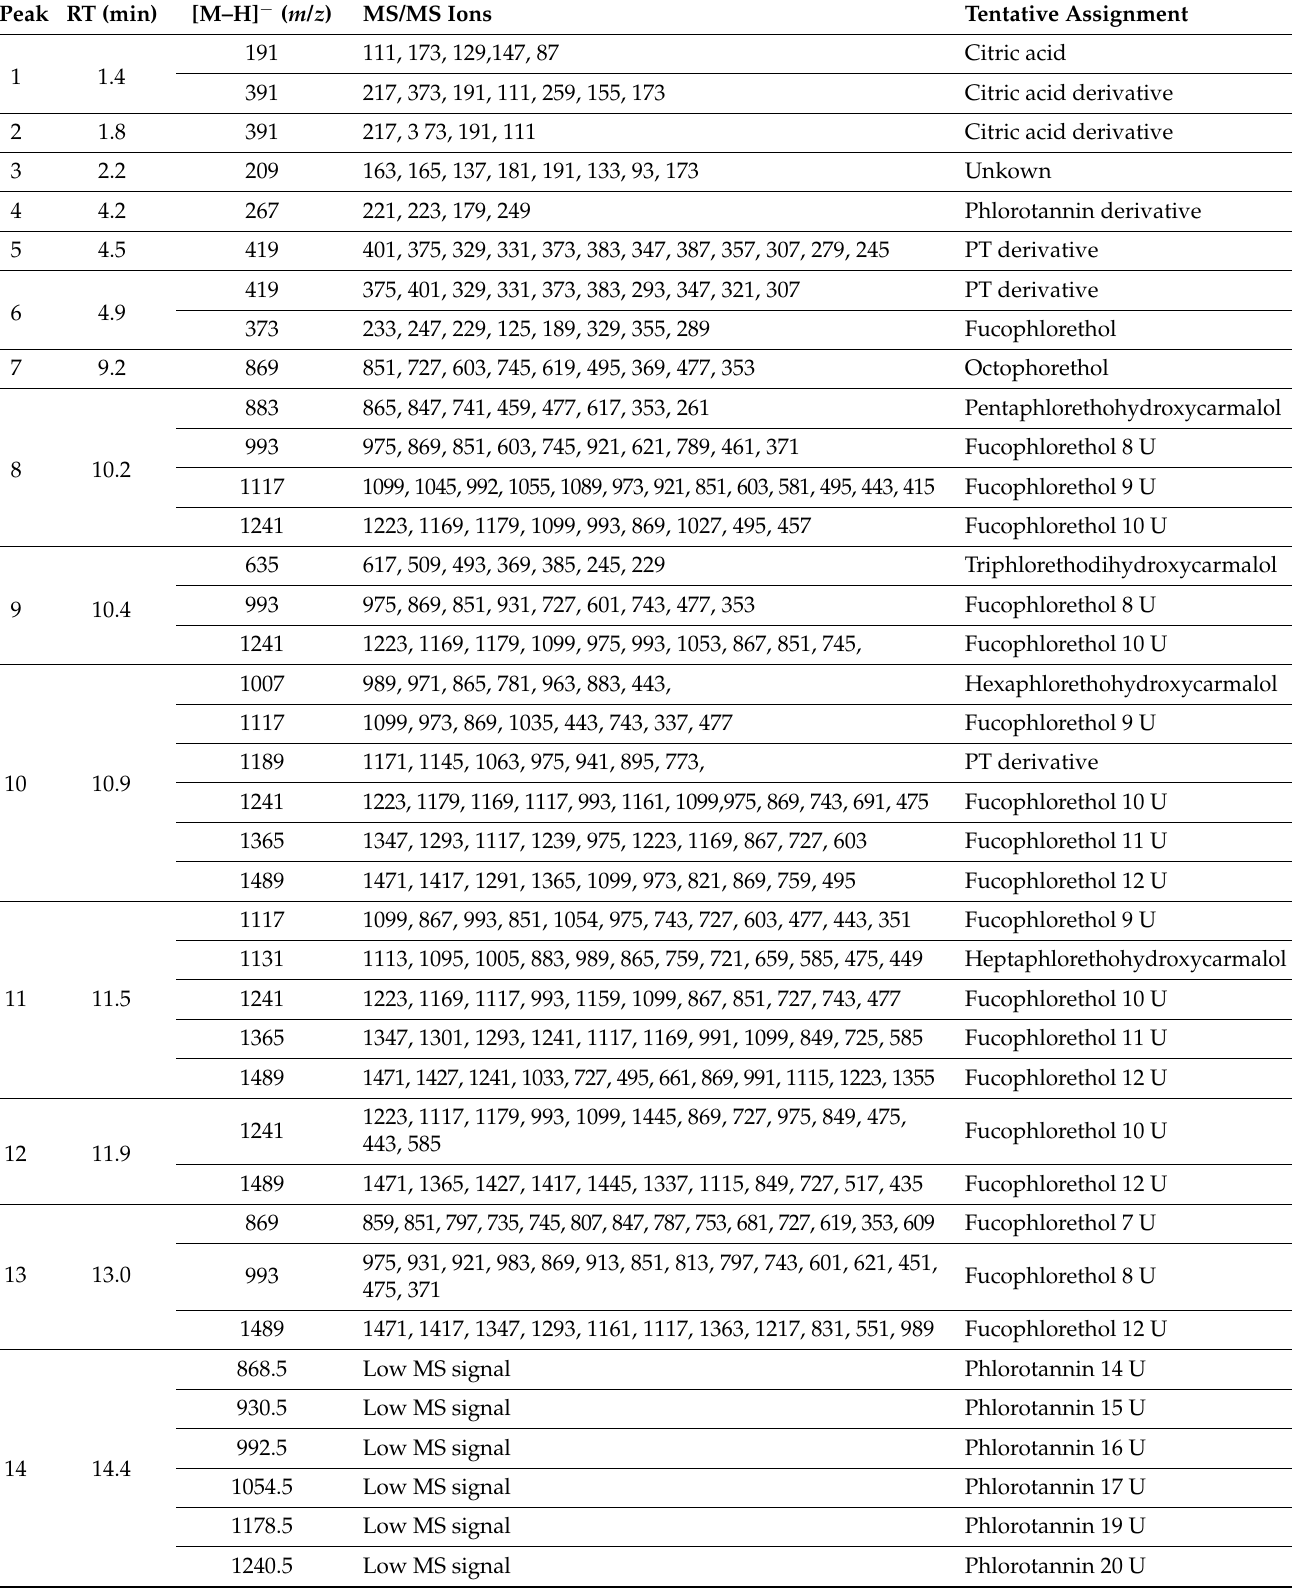
Table 2. Assignment of the compounds present in the ethyl acetate fraction of H. elongata extract analyzed by